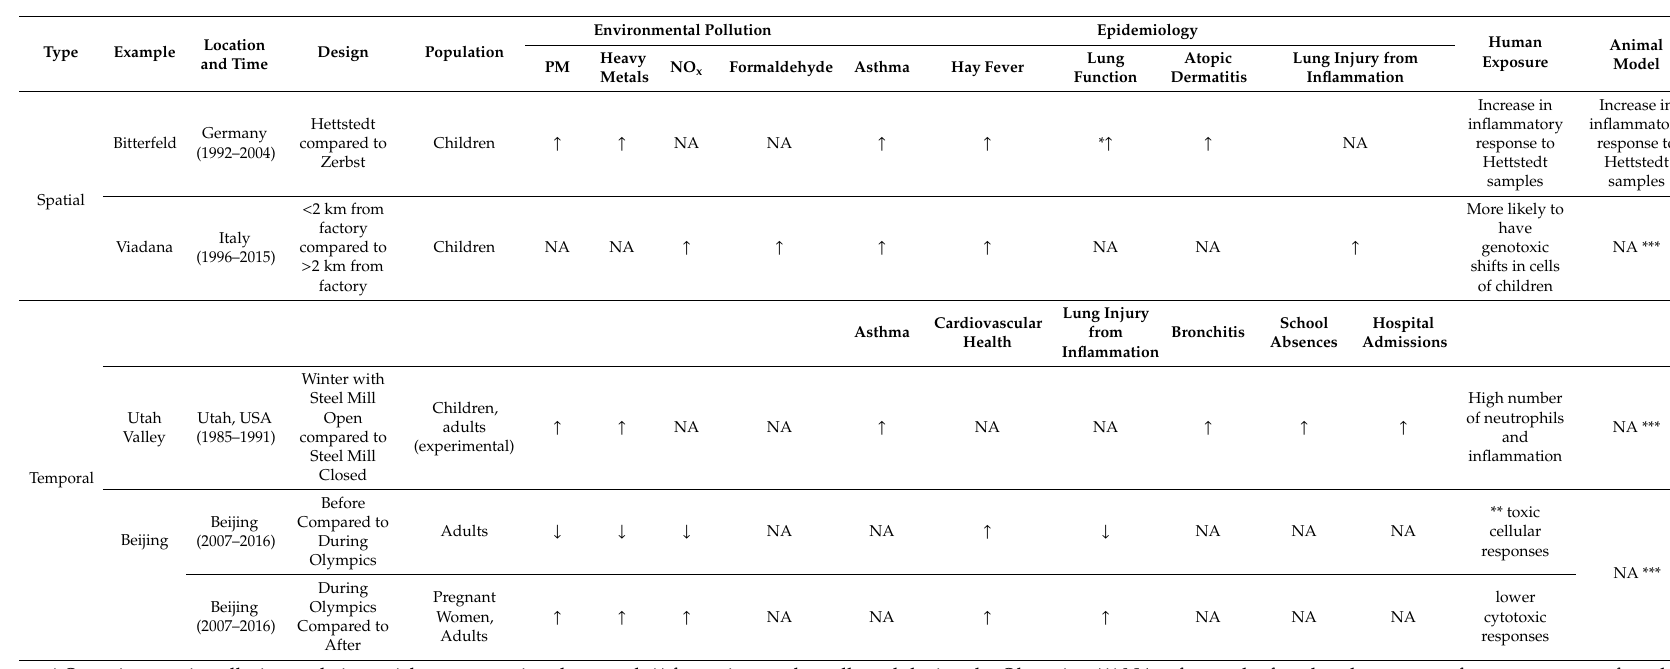
Table 2. Comparison of single-setting studies. This table compares the four studies (Bitterfeld, Utah Valley, Beijing, and Viadana) to show the pros and cons of each. Type Example